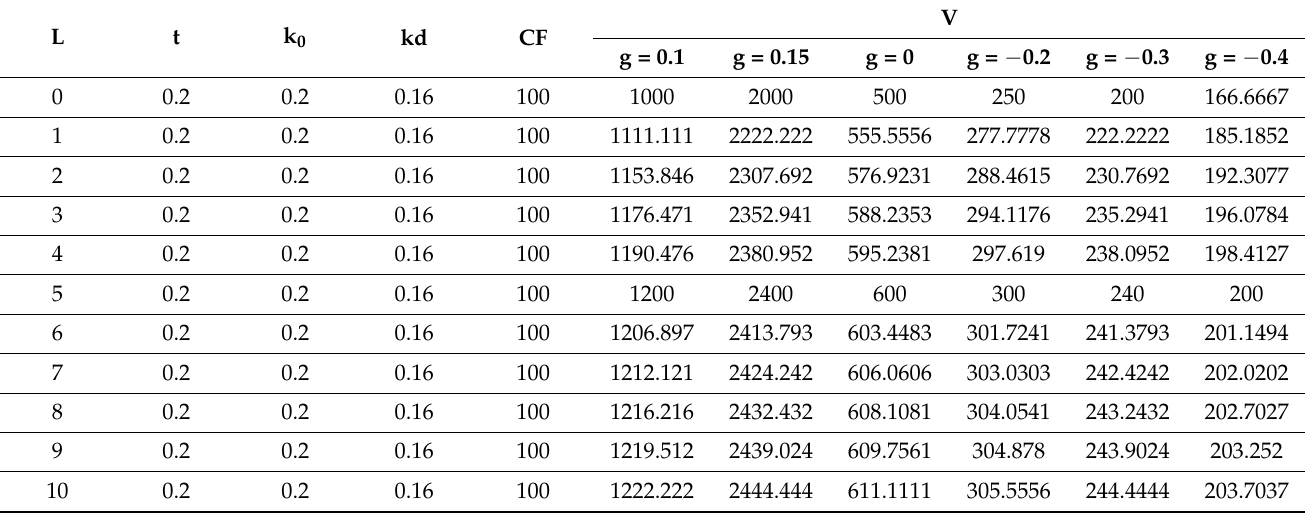
Table 5. Dependence of company value V on leverage level L in Generalized Modigliani–Miller theory (GMM theory)